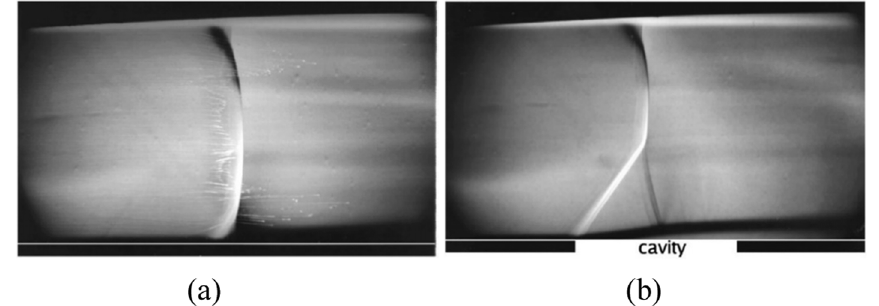
Fig. 10 Schlieren flow visualization ( a ) without and ( b ) with the porous cavity